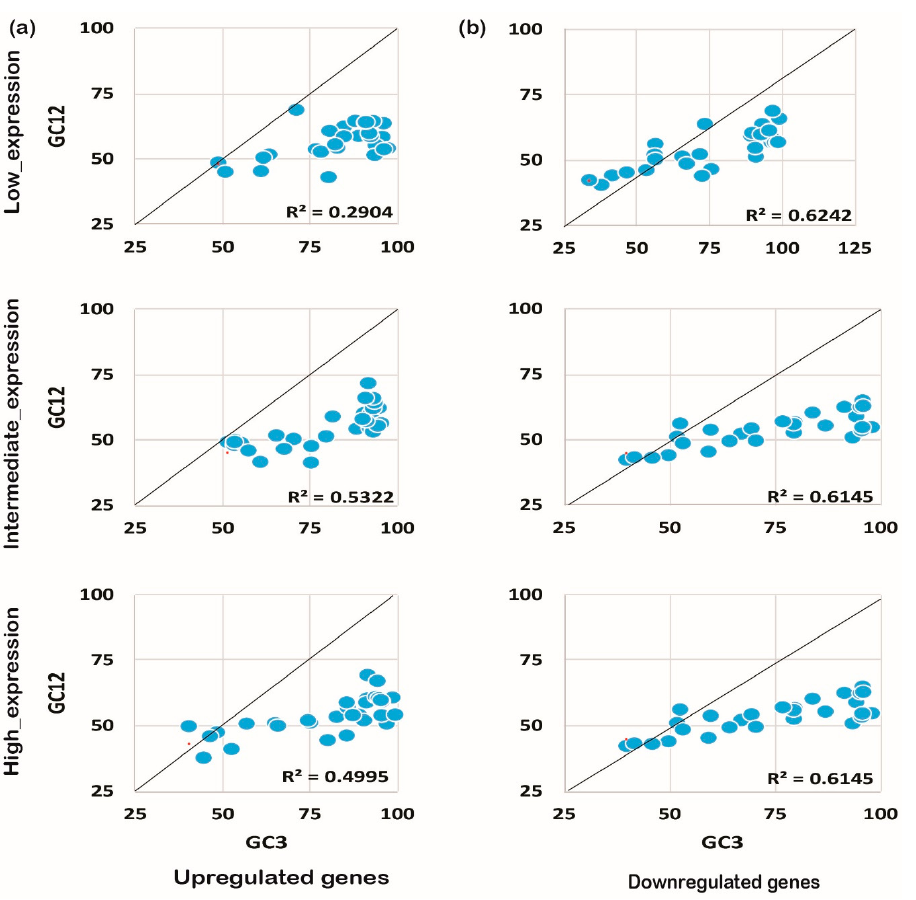
Figure 6. Neutrality plot analysis for genes expressed under abiotic stress. The expression pattern and the neutrality plot analysis for the genes expressed under biotic stress for upregulated ( a ) and downregulated ( b ) genes are evident.